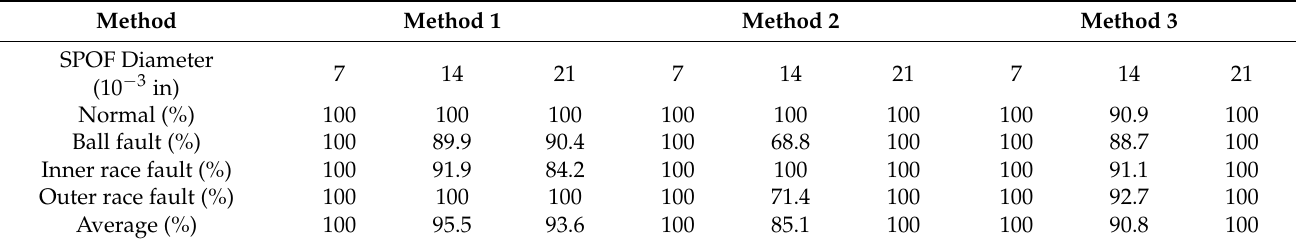
Table 9. Accuracy When HP = 1.